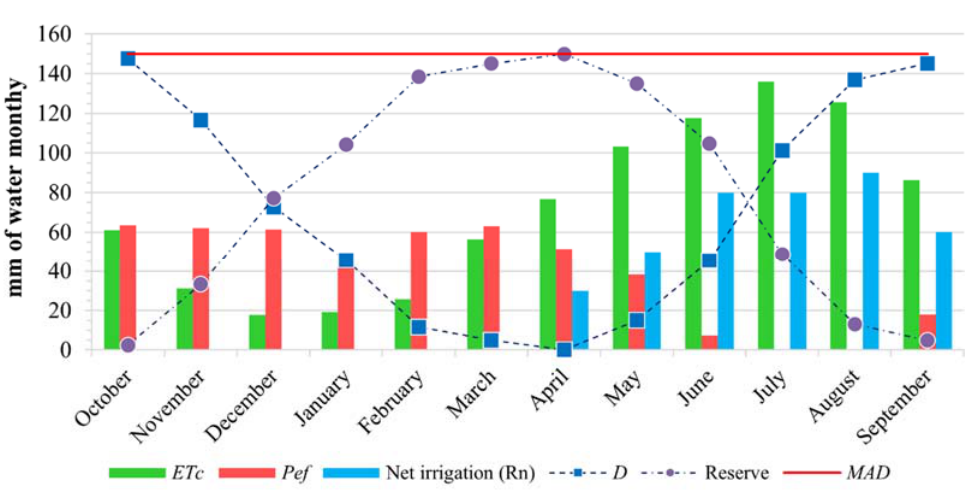
Figure 5. Monthly values of crop evapotranspiration ( ET c ), effective precipitation ( Pef ) and net irrigation scheduling. Irrigation has been programmed so that in the May–September period the reserve is gradually depleted in order to reach management allowable depletion soil water ( MAD ) at the end of September.